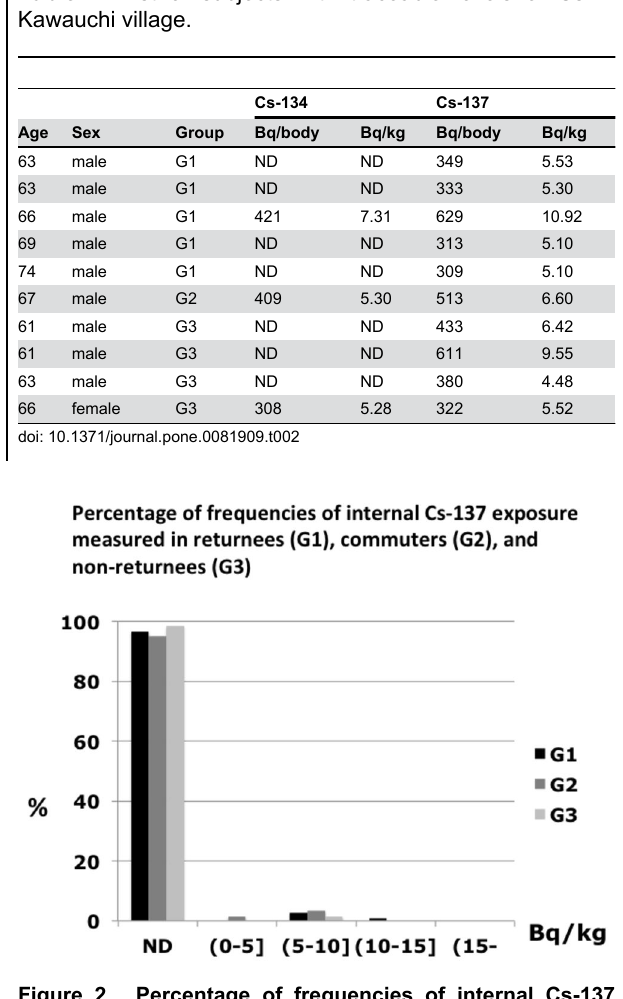
Figure 2. Percentage of frequencies of internal Cs-137 exposure measured in returnees (G1), commuters (G2), and non-returnees (G3) in 5 Bq/kg increments, the numbers of individuals included are 149 returnees, 61 commuters and 127 non-returnees. ND: not detected.